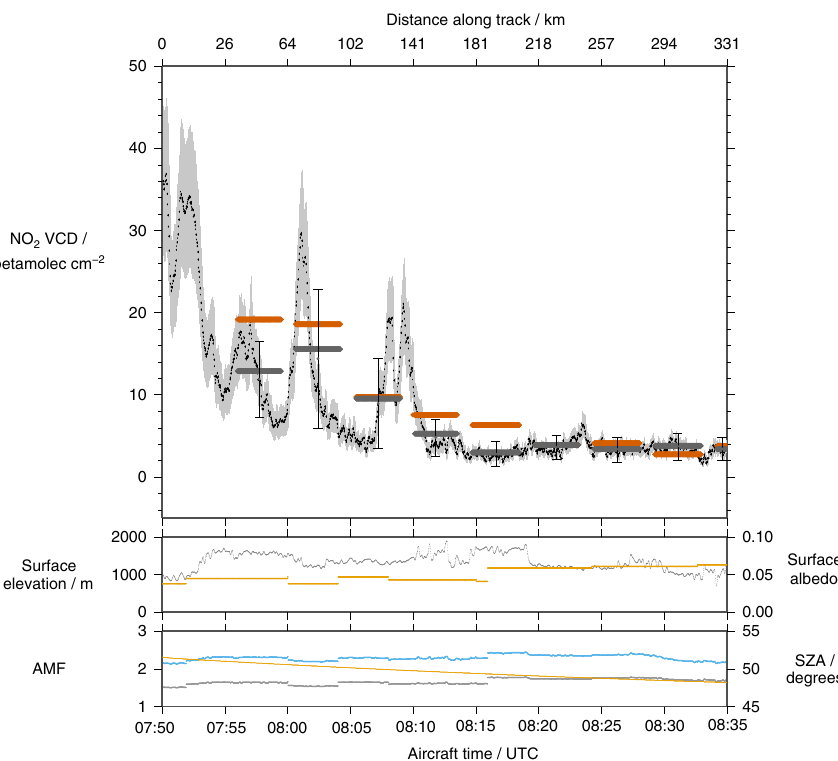
Figure 17. A time series of the airborne DOAS NO 2 vertical column densities on 14 August 2007, and SCIAMACHY at aircraft nadir (orange). Aircraft measurements averaged over the length of each SCIAMACHY pixel are shown in grey. Sub-plots are as described for Fig.